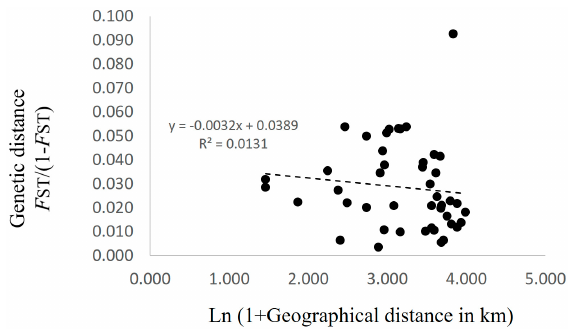
Figure 2. Relationship between the matrix of pairwise differentiation for F ST /(1 − F ST ) and the matrix of the natural logarithm of geographic distance in the 10 populations in Nagano prefecture, Japan. Table 2. Results of analysis of molecular variance (AMOVA) on the contribution of each source to total variation.